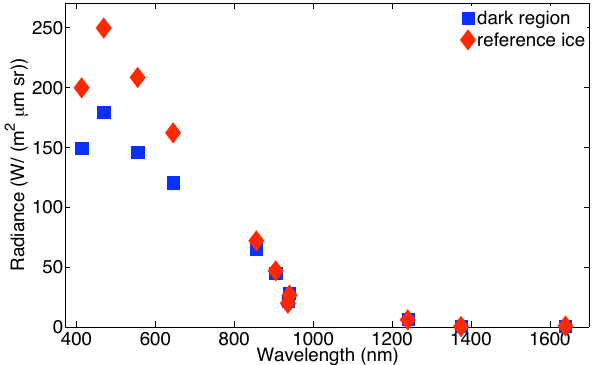
Fig. 6. Reflectances for a part of the dark region and for reference ice, as a function of wavelength, for 9 August 2007. Lines are mea- sured reflectances for glacier ice and dirty honeycomb glacier ice by Zeng et al. (1984).